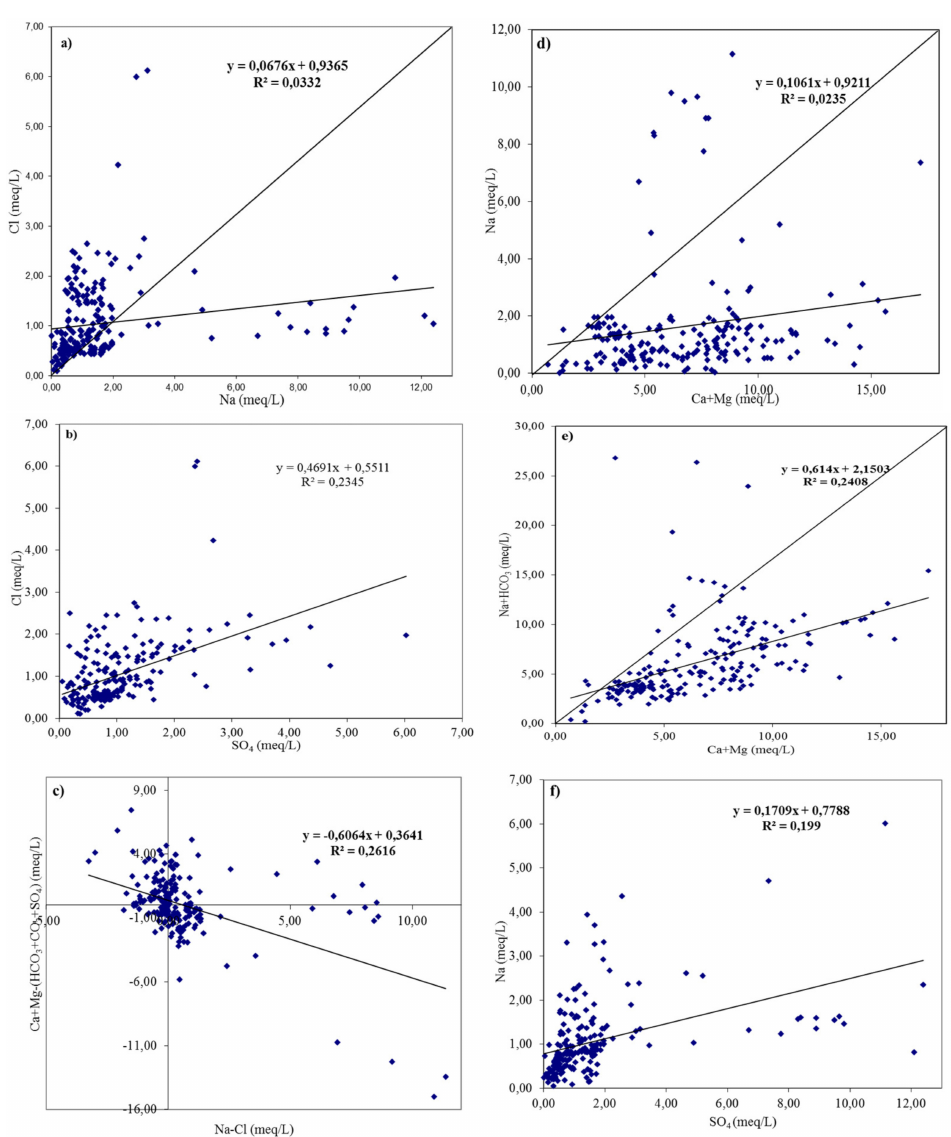
Figure 21. Major cation and anion relationships with ionic ratios ( a ) Na + vs. Cl − , ( b ) SO 4 2 − vs. Cl − , ( c ) Na + -Cl − vs. Ca 2+ +Mg 2+ -(HCO 3 − +CO 3 2 − +SO 4 2 − ), ( d ) Na + vs. Ca 2+ +Mg 2+ , ( e ) Ca 2+ +Mg 2+ vs. Na + +HCO 3 − , ( f ) Na + vs. SO 4 2 − on water